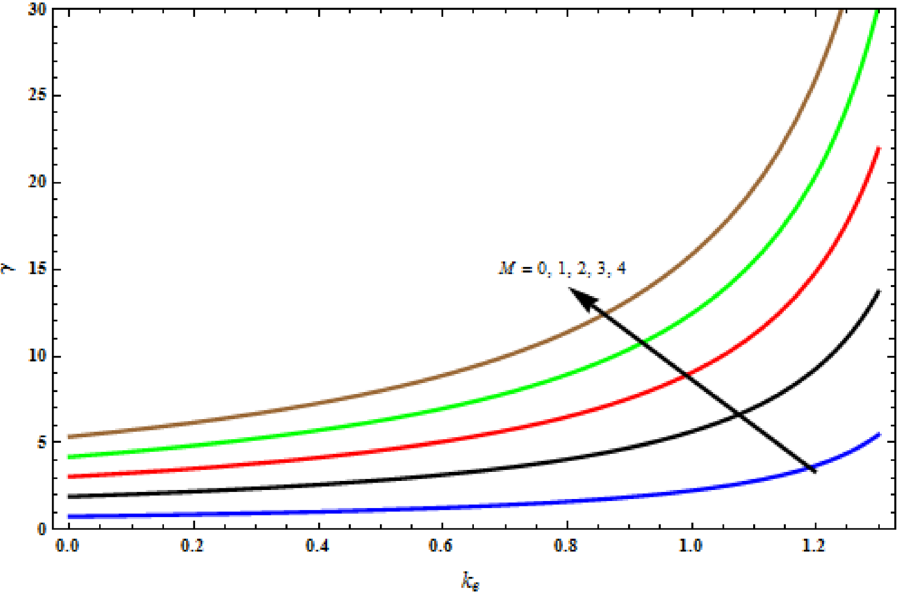
Figure 2. Critical curves illustrating k 1 versus γ with Pr = 1, Da -1 = 1, τ = 90° for stretching case.